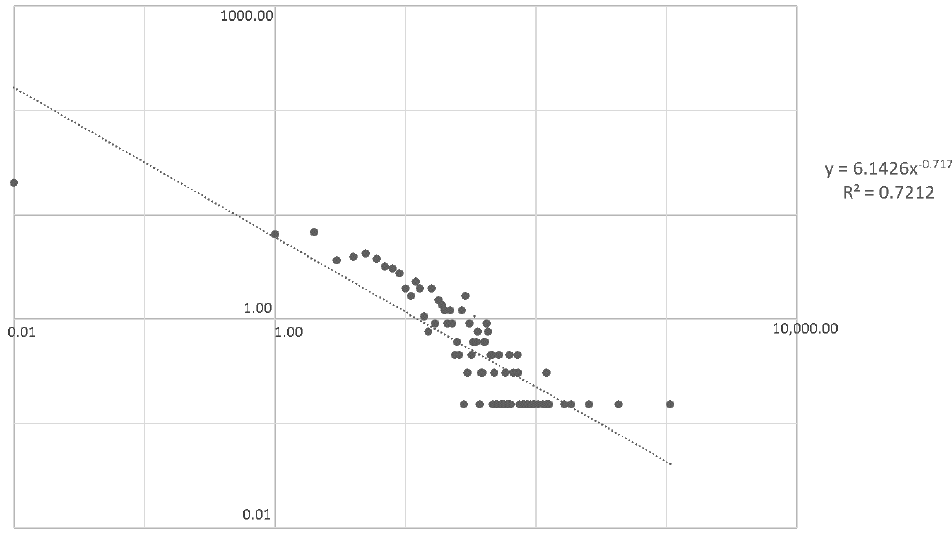
Figure 4. Distribution of cites per year. The distribution of cites per year from 1991 to 2020 shows a power law with a negative exponent (R 2 = 0.721), in keeping with the Bradford law, demonstrating the rising interest in this field of